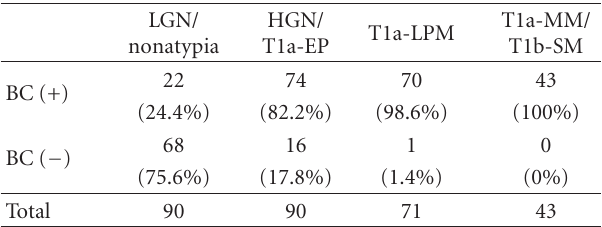
Table 2: Significant correlation was seen between tumor depth and presence of BC, P < 0 .